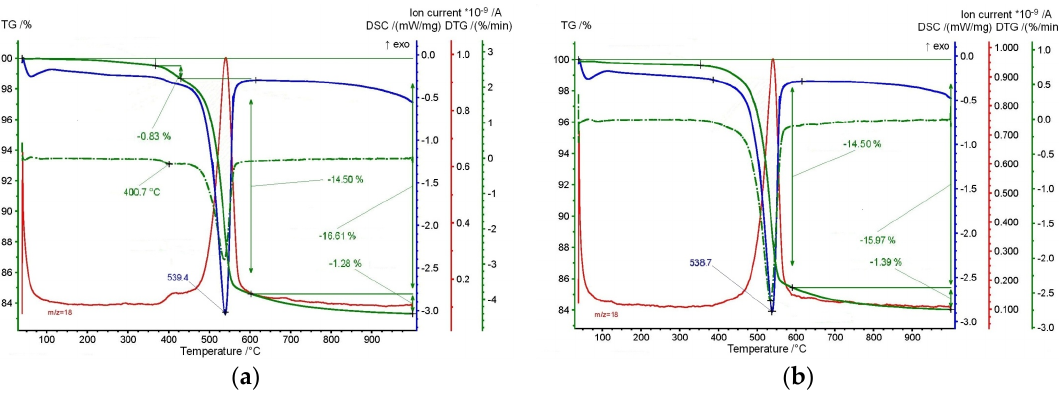
Figure 6. The thermal curves of products of HTT of χ -Al 2 O 3 , obtained at ( a ) T = 200 ◦ C, τ = 180 min, pH = 9.2 and ( b ) the sample after heating up to 400 ◦ C (10 ◦ C/min). Closed mesopores are formed by splicing large crystals of boehmite only with the shape of parallelepipeds and rhombi when their concentration in the samples reaches ~25 wt %.